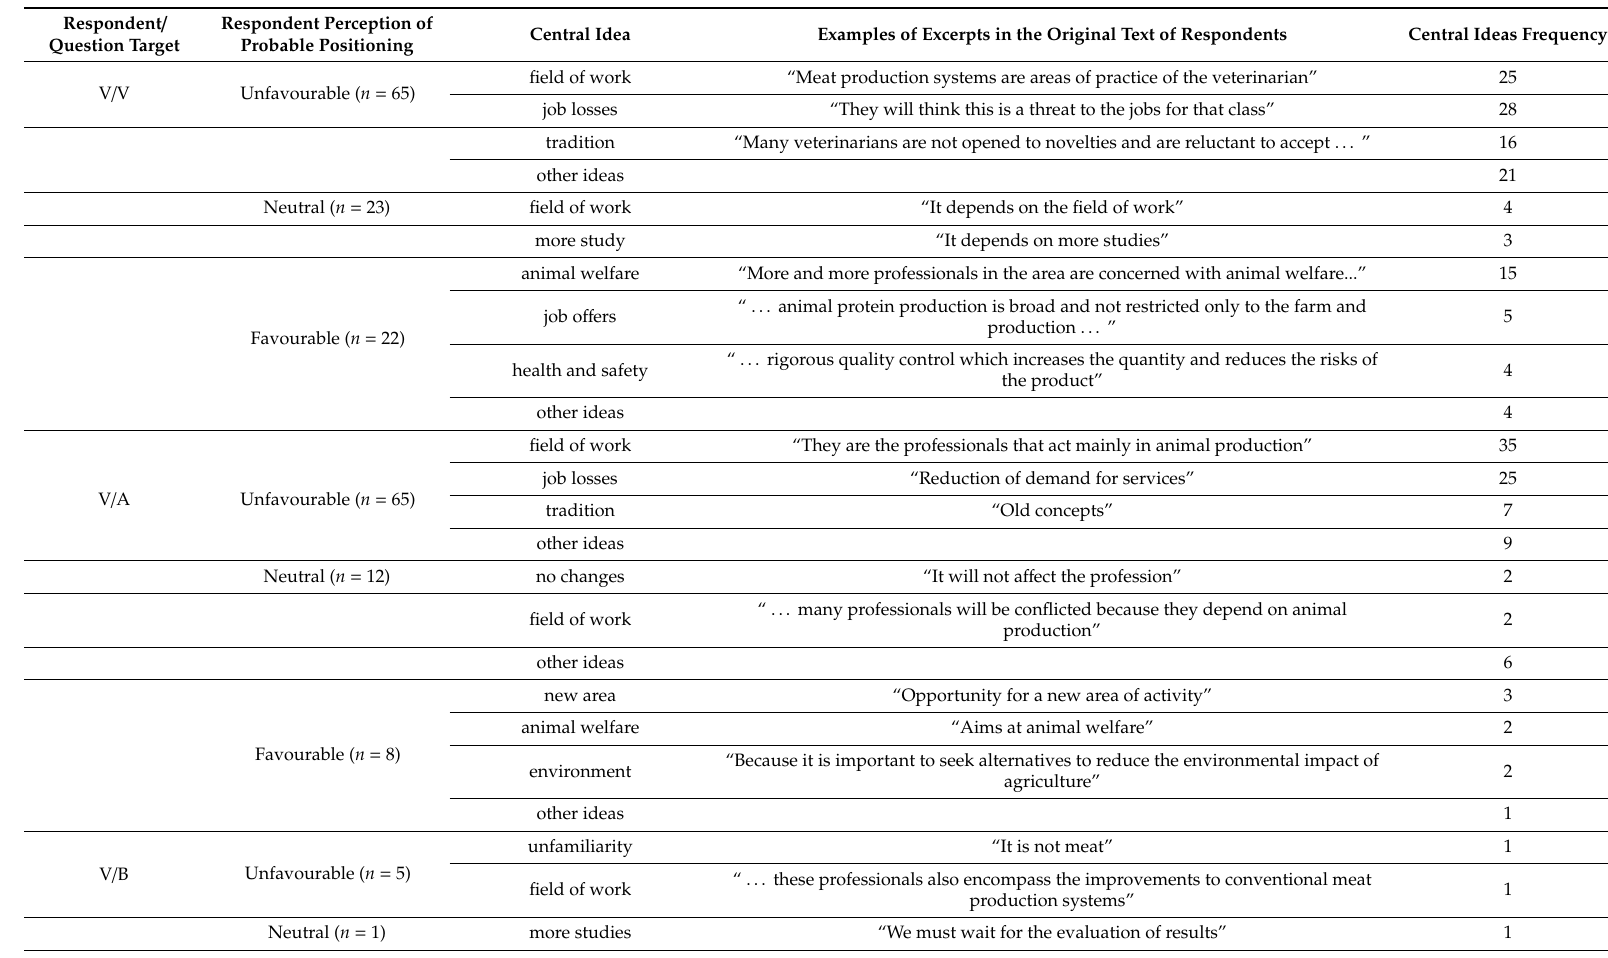
Table 3. Discourse of the Collective Subject results for answers on the perception of 209 Brazilian veterinarians (V) and 63 animal scientists (A) regarding probable positioning of veterinarians, animal scientists and bioprocess engineers (B) in relation to cell-based meat, according to an online